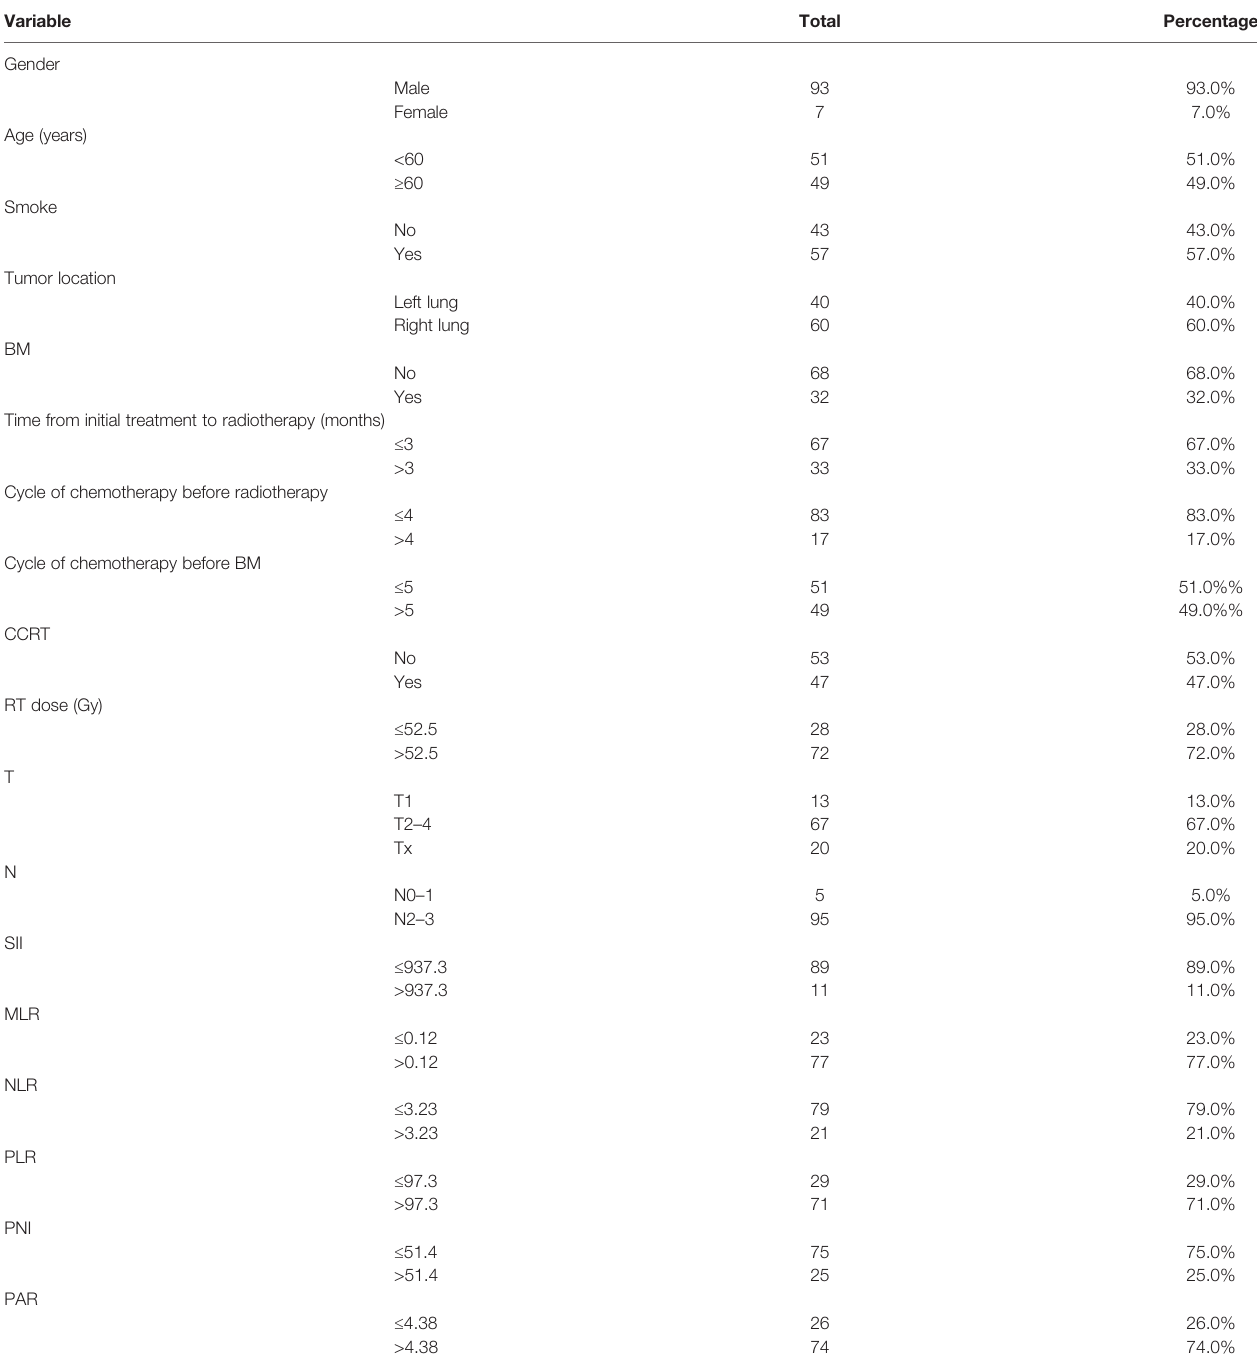
TABLE 1 | Baseline characteristics of